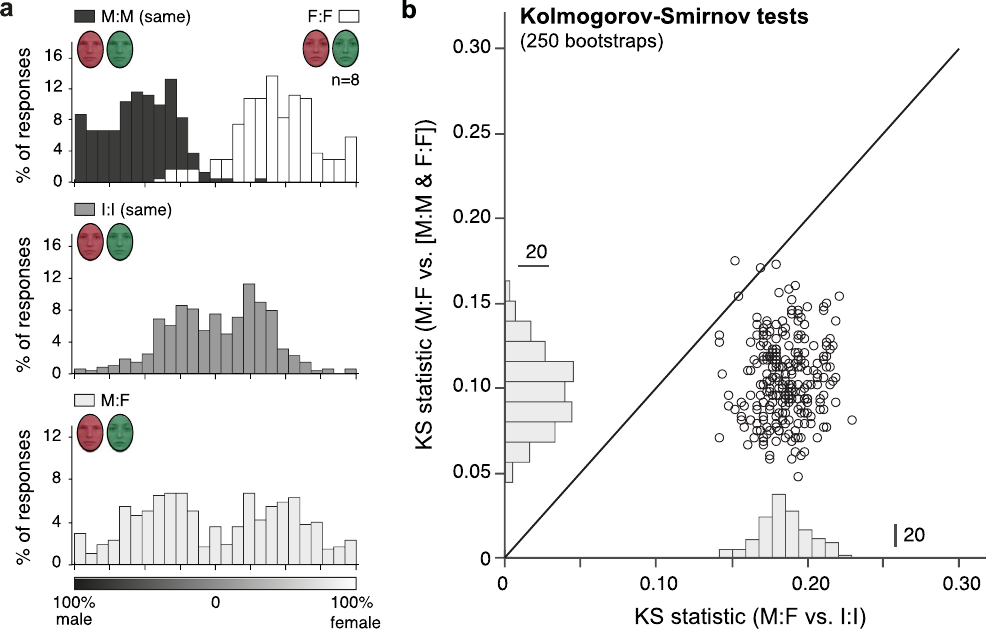
Figure 3. Monocular grouping cues prevent interocular merging of face images. ( a ) Gender rating distributions of Experiment 5. Individual eyes were presented with either two of the same male (M:M) or female (F:F) faces, a male and a female face (M:F), or two identical intermediate morph faces (I:I) overlaid with an eye-specific color (red or green). Observers indicated the perceived gender of each stimulus presentation on a continuous scale from fully male to fully female. ( b ) KS-statistics for 250 bootstrapped comparisons of the distributions in ( a